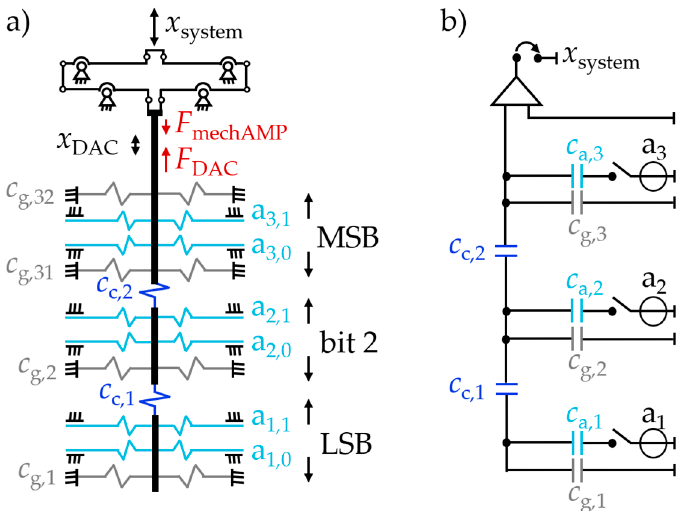
Figure 2. ( a ) Structure of the system: the binary encoded discrete displacement of the DAC x DAC is amplified by the mechAMP, resulting in a large and still binary-encoded discrete system displacement x system , ( b ) corresponding electrical network model. (drawings not to scale).